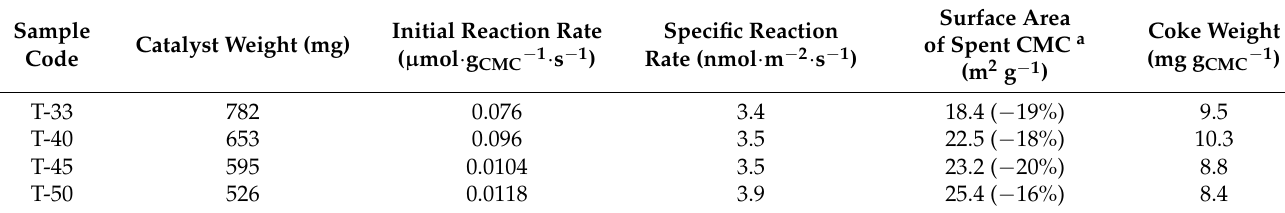
Table 3. Reaction rate over CMCs in the RF-flow